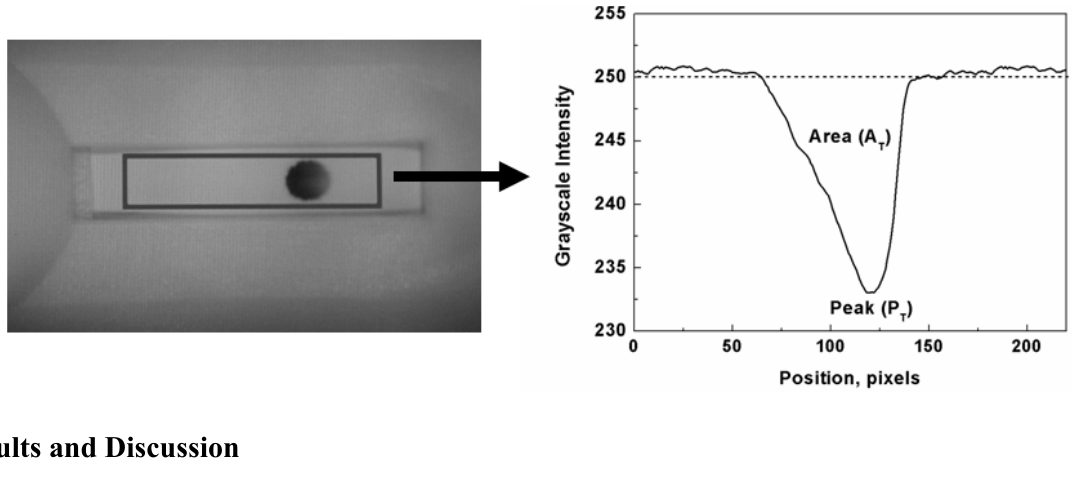
Figure 3. Typical photo image and intensity profile of detection area.